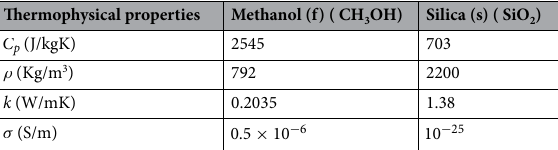
Table 2. Thermophysical features of the Silica (SiO 2 ) nanoparticles and the methanol (CH 3 OH) base fluid.